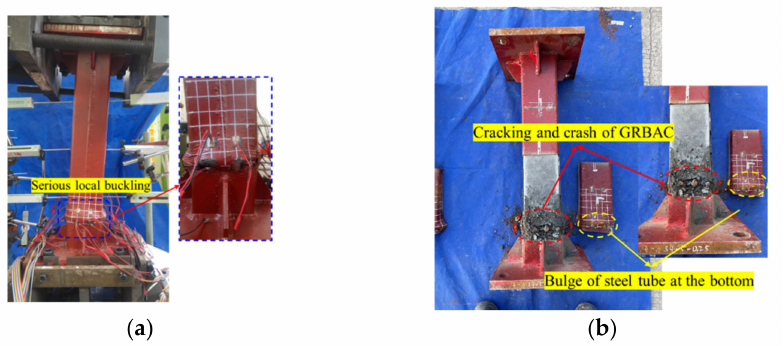
Figure 5. ( a ) Final overall failure mode of concrete for STG4-0.5-0.25; ( b ) damage of inner concrete of concrete for STG4-0.5-0.25.